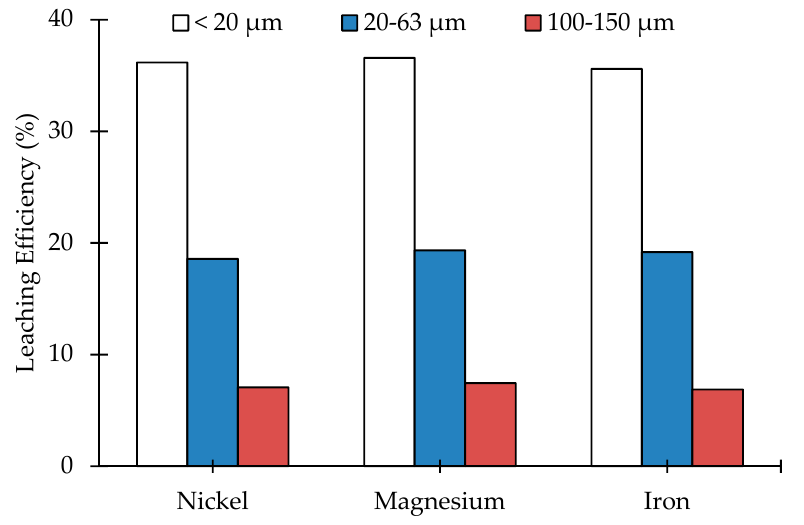
Figure 7. Leaching e ffi ciency depending on particle size, 50 ◦ C, 60 min, 1 M HCl and 300 rpm.